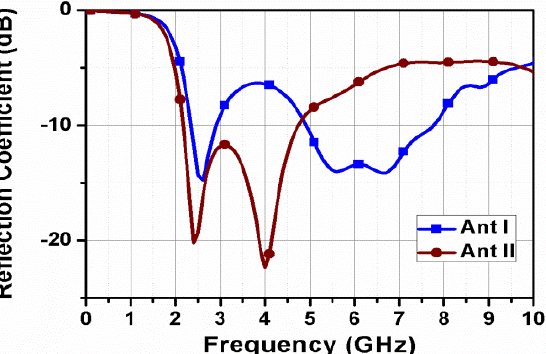
Figure 6. Evolution of the antennas linked with P2 to P9.